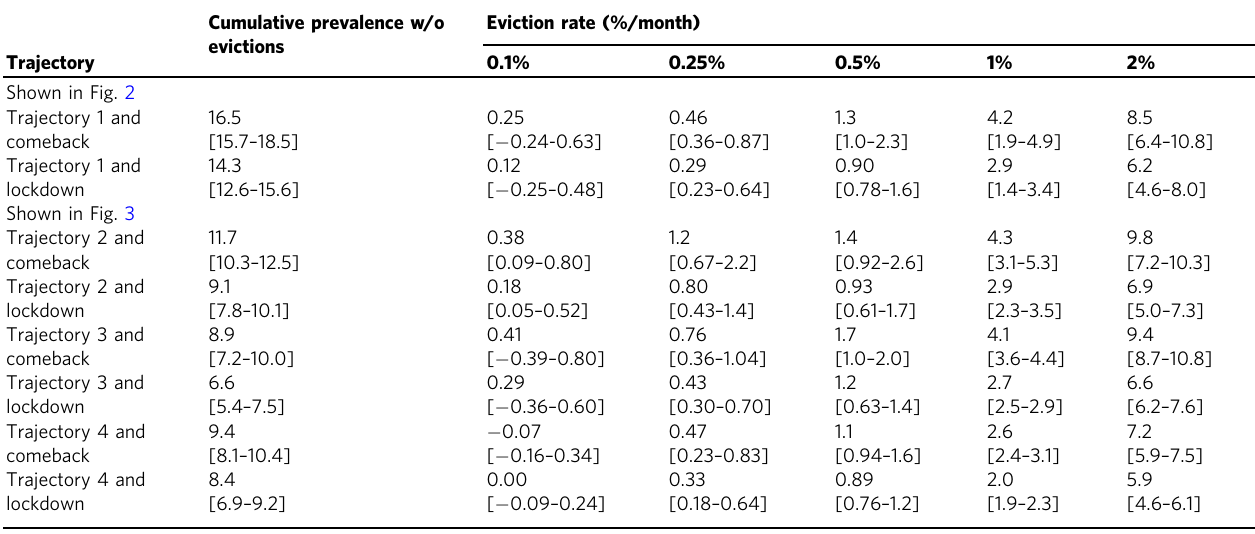
Table 1 Predicted excess SARS-CoV-2 infections when evictions are